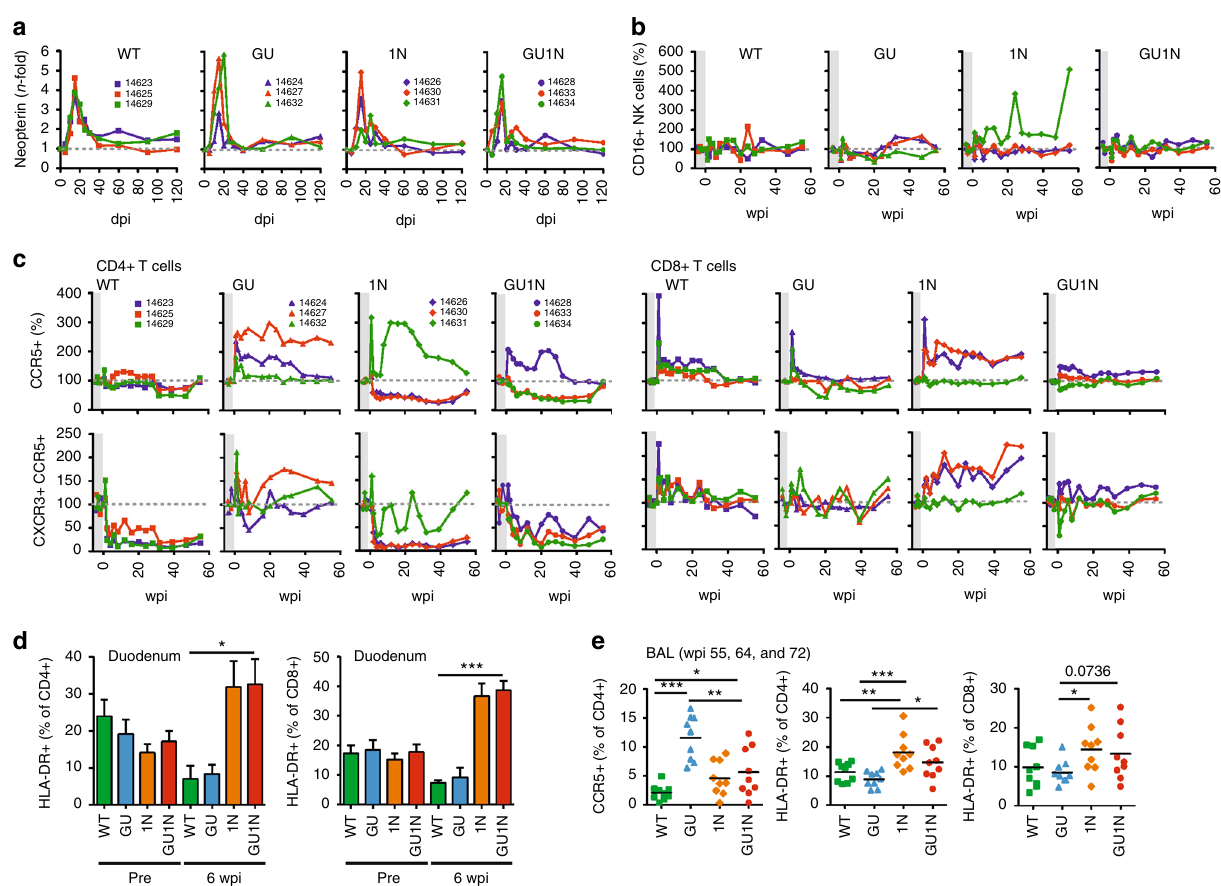
Fig. 3 Immunological fi ndings during the fi rst year of HIV-1-like SIVagm infection. a Increase of urinary neopterin levels at the indicated days post-infection (dpi) relative to the values measured prior to SIV infection. b , c Levels of CD16 + NK ( b ) and CCR5 + or CXCR3 + /CCR5 + CD4 + (left) and CD8 + (right) T cells ( c ) at the indicated weeks post-infection (wpi) relative to the baseline values (100%). The shaded area indicates time points prior to infection. d Percentages of activated HLA-DR + CD4 + and CD8 + T cells in duodenum prior to infection and at six wpi. Shown are mean values obtained for the three animals per group ( + SEM). e Percentages of CCR5 + CD4 + T cells and activated HLA-DR + CD4 + and CD8 + T cells in bronchoalveolar lavage obtained at 55, 64, and 72 wpi. p -values were calculated using the two-tailed unpaired Student's- t -test and signi fi cant differences are indicated as: * p < 0.05; ** p < 0.01; *** p <